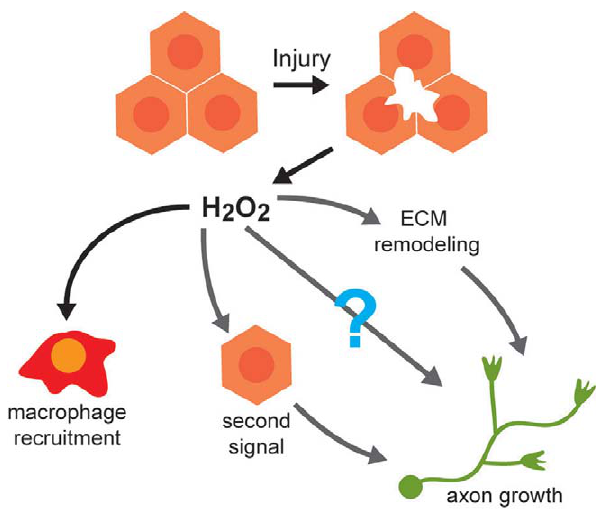
Figure 8. Skin injury and H 2 O 2 promote peripheral axon regeneration. H 2 O 2 is generated in response to keratinocyte injury and elicits two independent responses to injury: (1) the recruitment of macrophages to the wound margin [13], and (2) the promotion of peripheral sensory axon growth in the skin. H 2 O 2 ’s axon growth- promoting role requires neither leukocytes nor H 2 O 2 production in neurons themselves. H 2 O 2 may be promoting axon regeneration by eliciting a second signal (most likely from keratinocytes) that in turn acts on axons, remodeling the extracellular matrix to allow axon growth, or by directly acting on axons, perhaps by blocking their response to inhibitors.